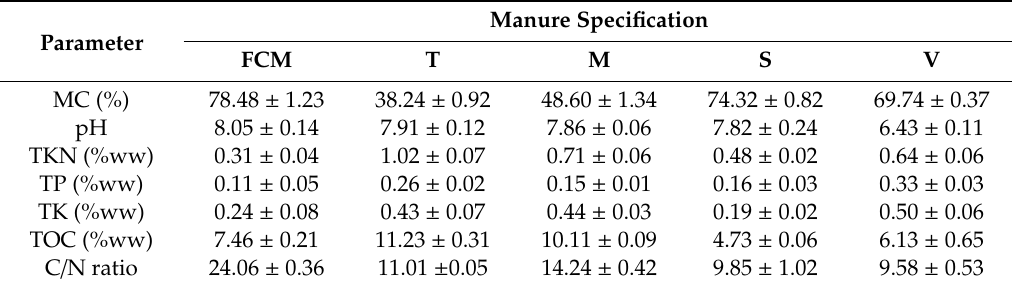
Table 1. Physio-chemical composition of cattle manure and derived